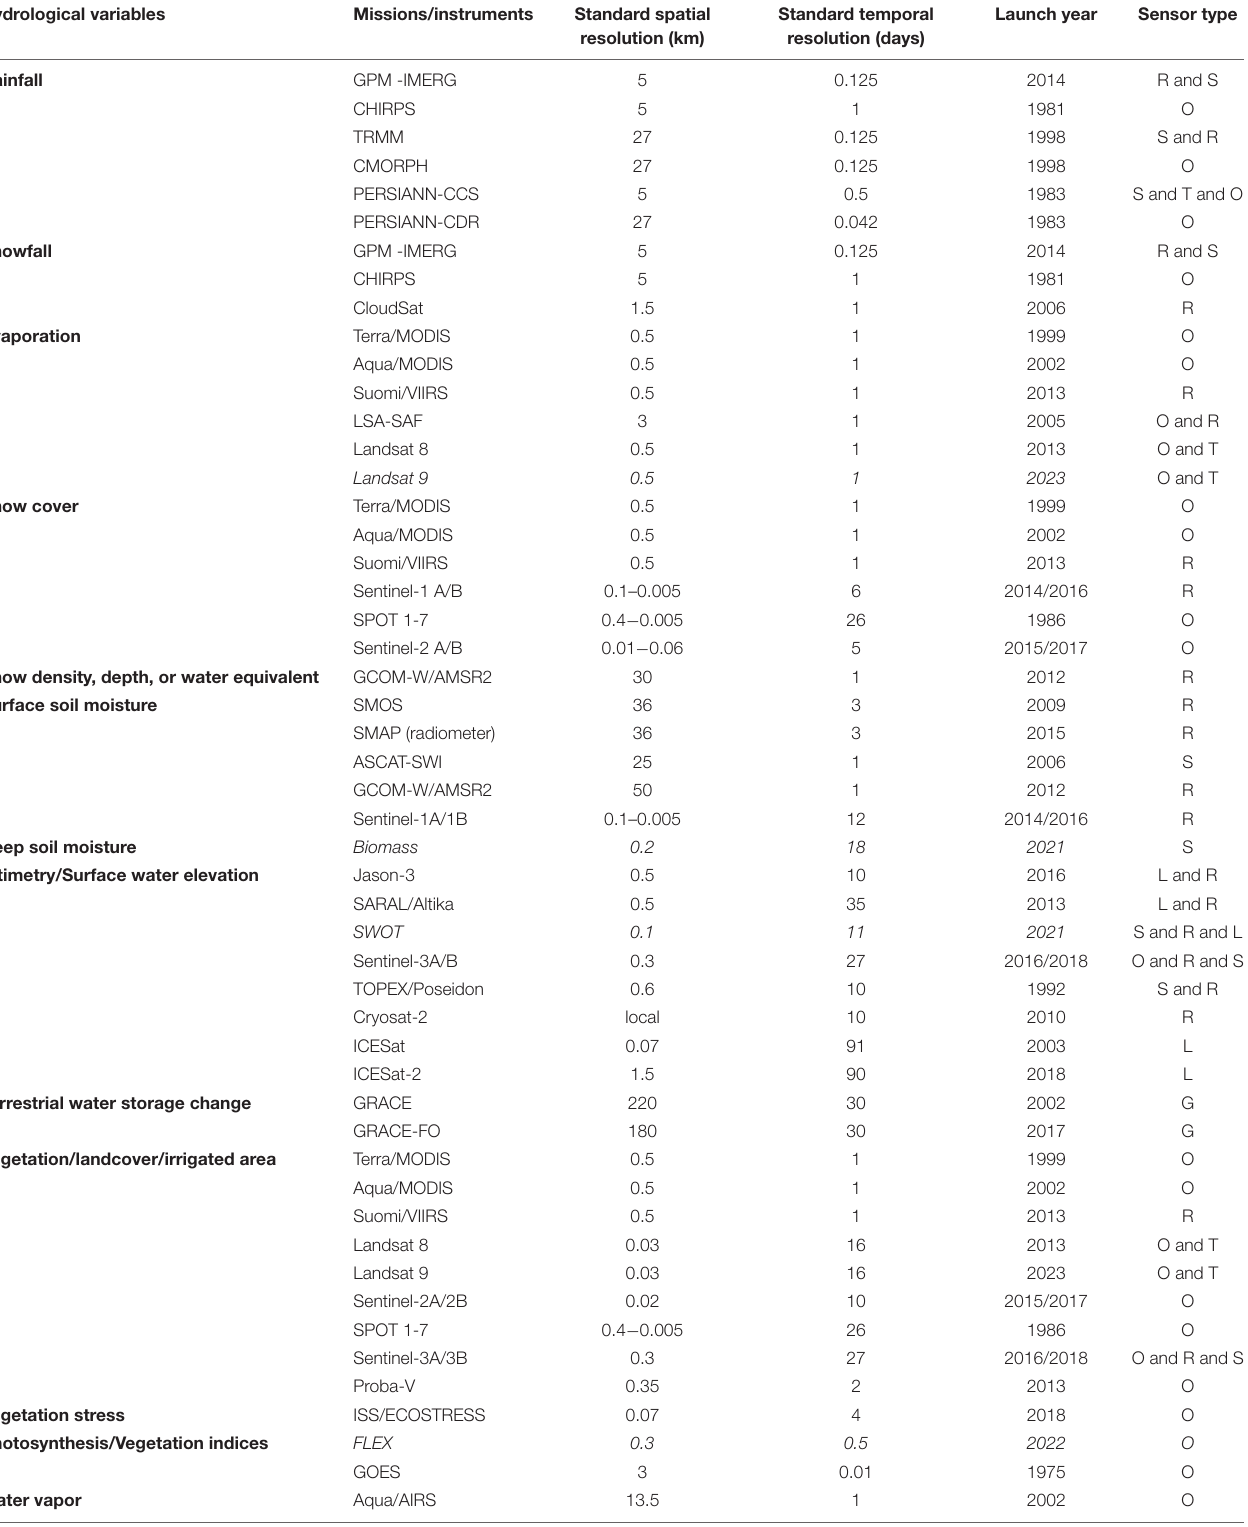
TABLE 4 | (non-exhaustive overview) Hydrological variables corresponding to current and planned (in italic) satellite remote sensing missions. Hydrological